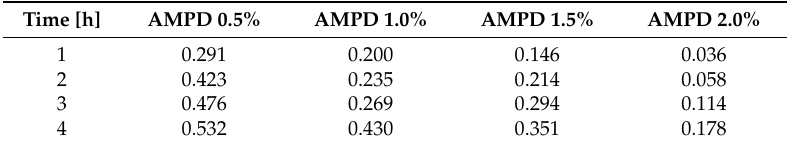
Table 2. Changes in the turbidity of AMPD solutions with various concentrations over model skin sebum ( n = 1).